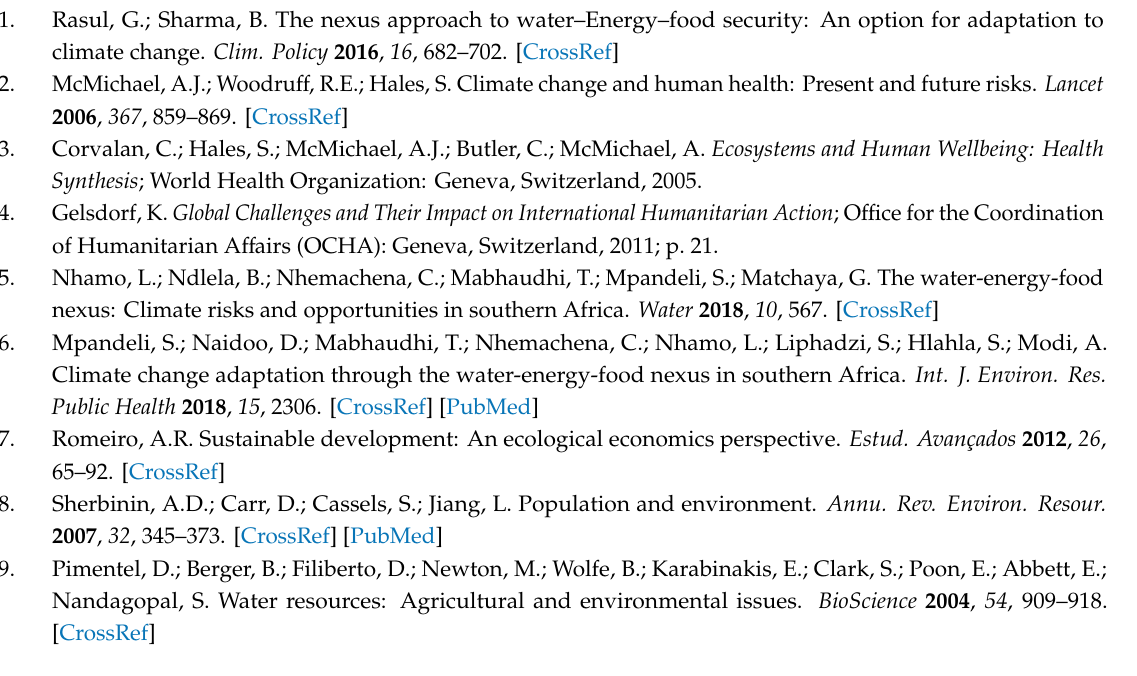
Figure S1: Schematic summary of main pathways by which climate change a ff ects livelihoods, human wellbeing and health, and how they are related to the WEF nexus. The pathways formed the basis to develop a systems approach that integrates water, food, and energy aspects by mapping key elements of the subsystems and visualising their